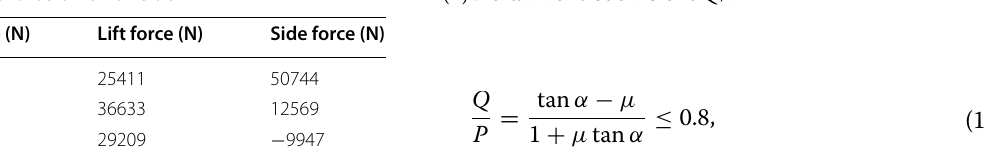
Table 4 Aerodynamic force of full-size train